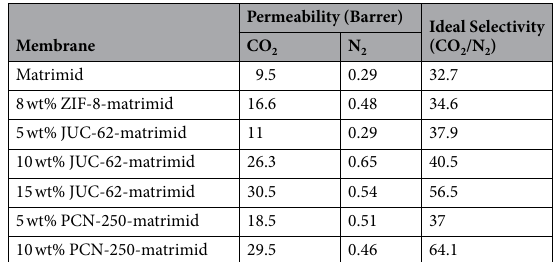
Table 2. Permeability and CO 2 /N 2 ideal selectivity for the membranes used in this